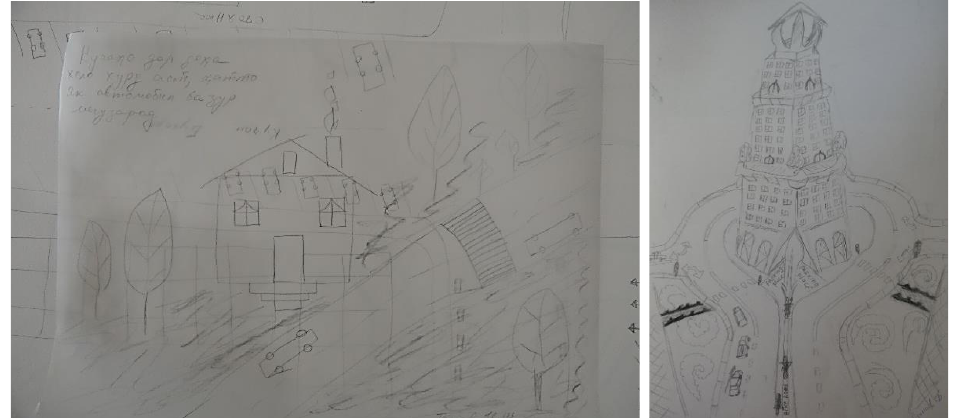
the Young Generation of Tajikistan).